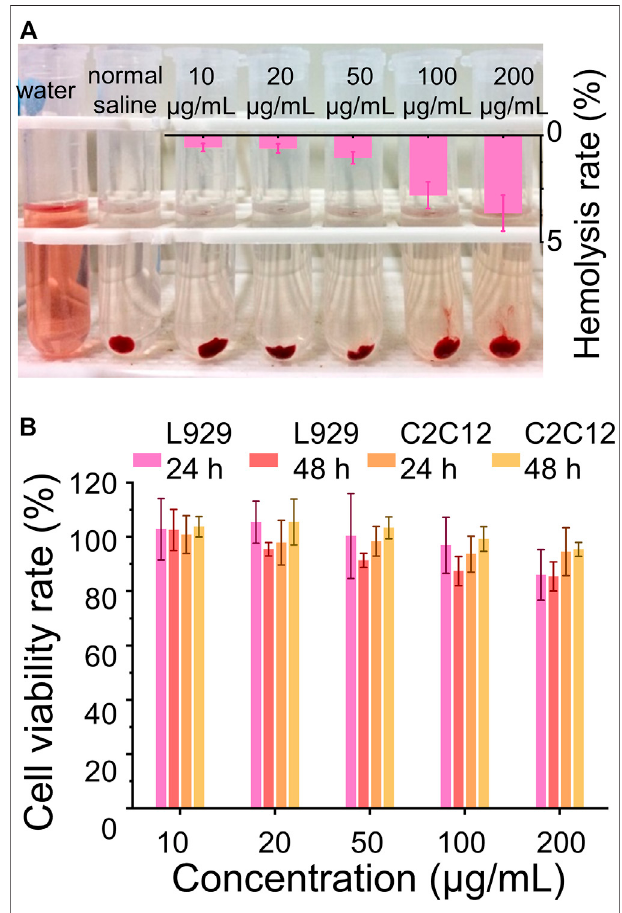
FIGURE 4 | Biocompatibility assay. (A) Hemolysis assay after the treatment with different concentrations of the MC NRs. (B) Cell viability rate of the L929 cells and C2C12 cells treated with CaCO 3 NRs for 24 and 48